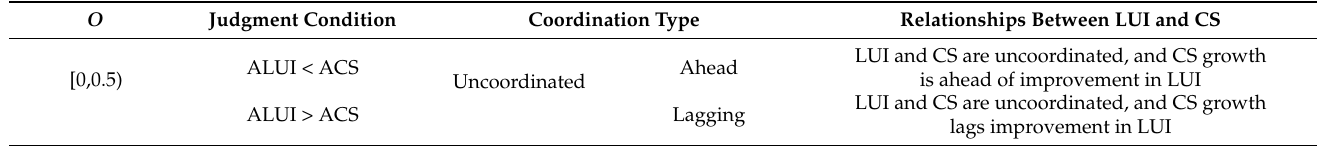
Table 2. Coordination types and relationships between land-use intensity (LUI) and carbon storage